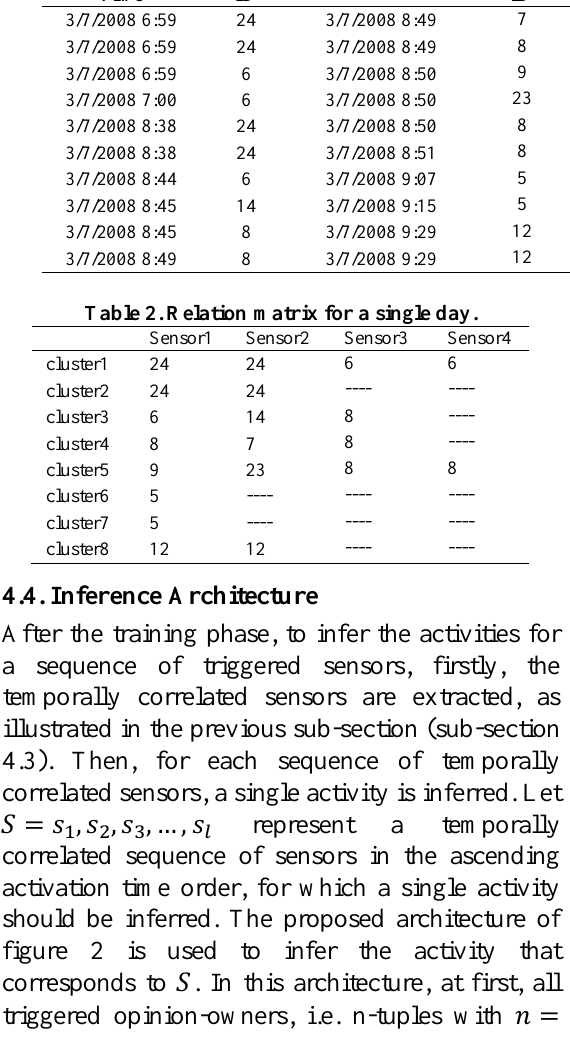
Table 1. Sensor activations for a single day. Activation